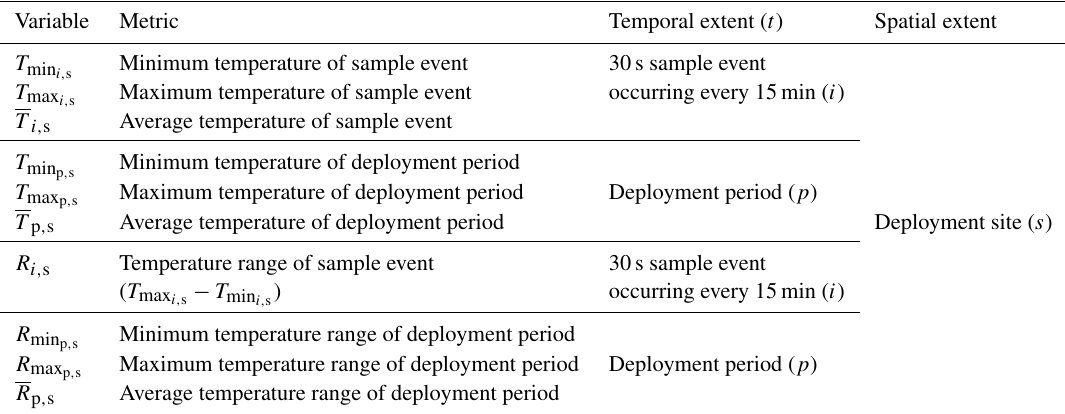
Table 1. Description of DTS stream temperature